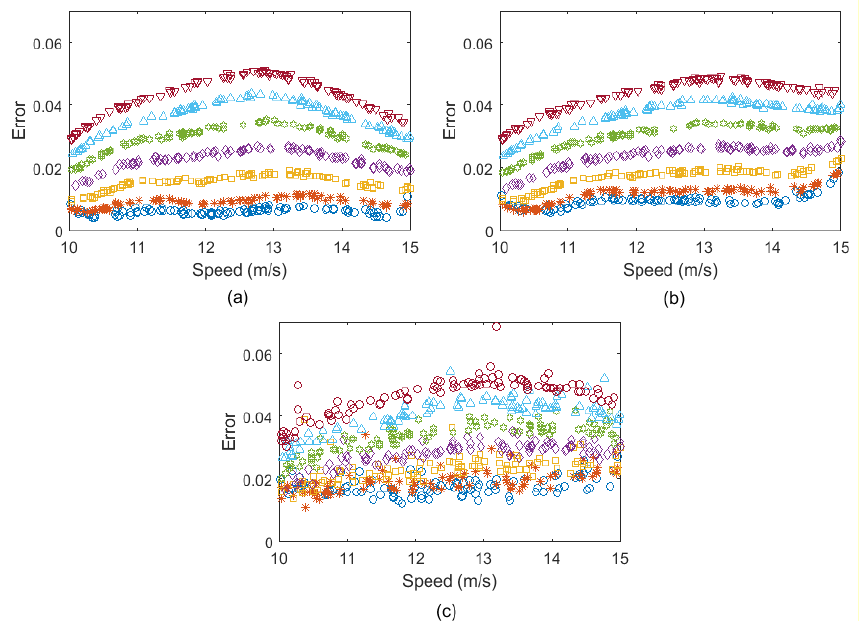
Figure 9. The prediction errors for ( a ) 1% added noise, ( b ) 3% added noise, and ( c ) 5% added noise (dark blue: healthy, red: 5% damage, yellow: 10% damage, purple: 15% damage, green: 20% damage, light blue: 25% damage, brown: 30% damage).